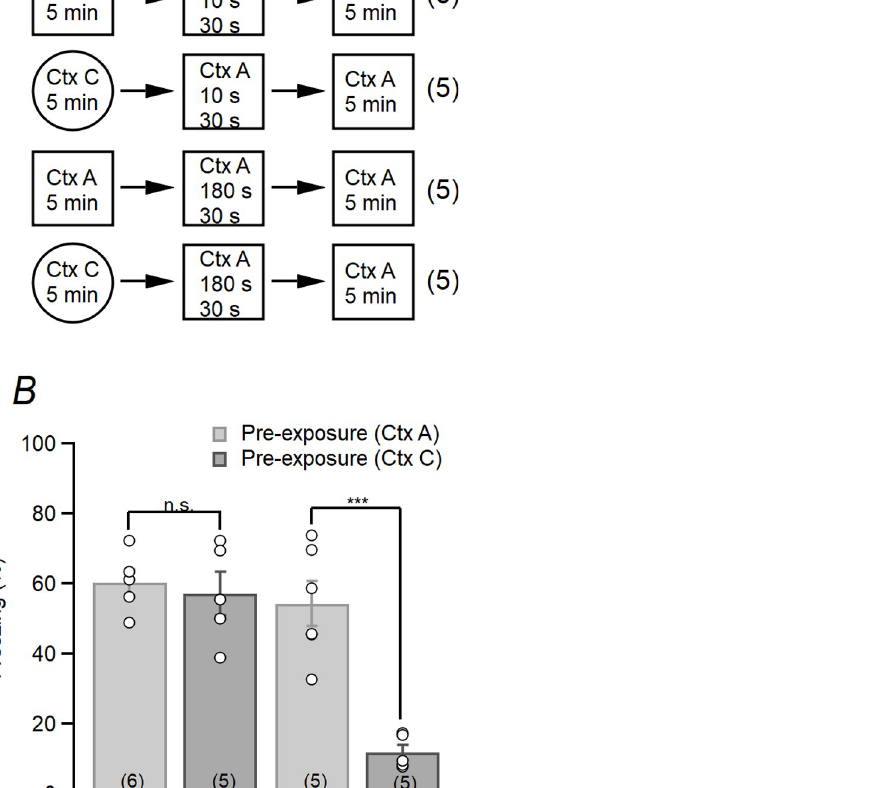
± 3.3 mm from longitudinal fissure) or dorsal CA3 (mediolateral, ca. ± 2.3 mm from longitudi- nal fissure). The sections were fixed in 4% PFA for 10 min, dehydrated in increasing concen- trations of ethanol (50%, 70%, and 100%) for 5 min, and finally air-dried. The fixed tissues were pretreated for protease digestion for 30 min at room temperature. The digested tissues were hybridized with appropriate H1a and Arc riboprobes according to instructions in manu- facturer’s manual and previous studies and visualized to measure neural ensembles [21, 28]. Nuclei were counterstained with 4 0 ,6-diamidino-2-phenylindole (DAPI; Tocris bioscience, Bristol, UK).